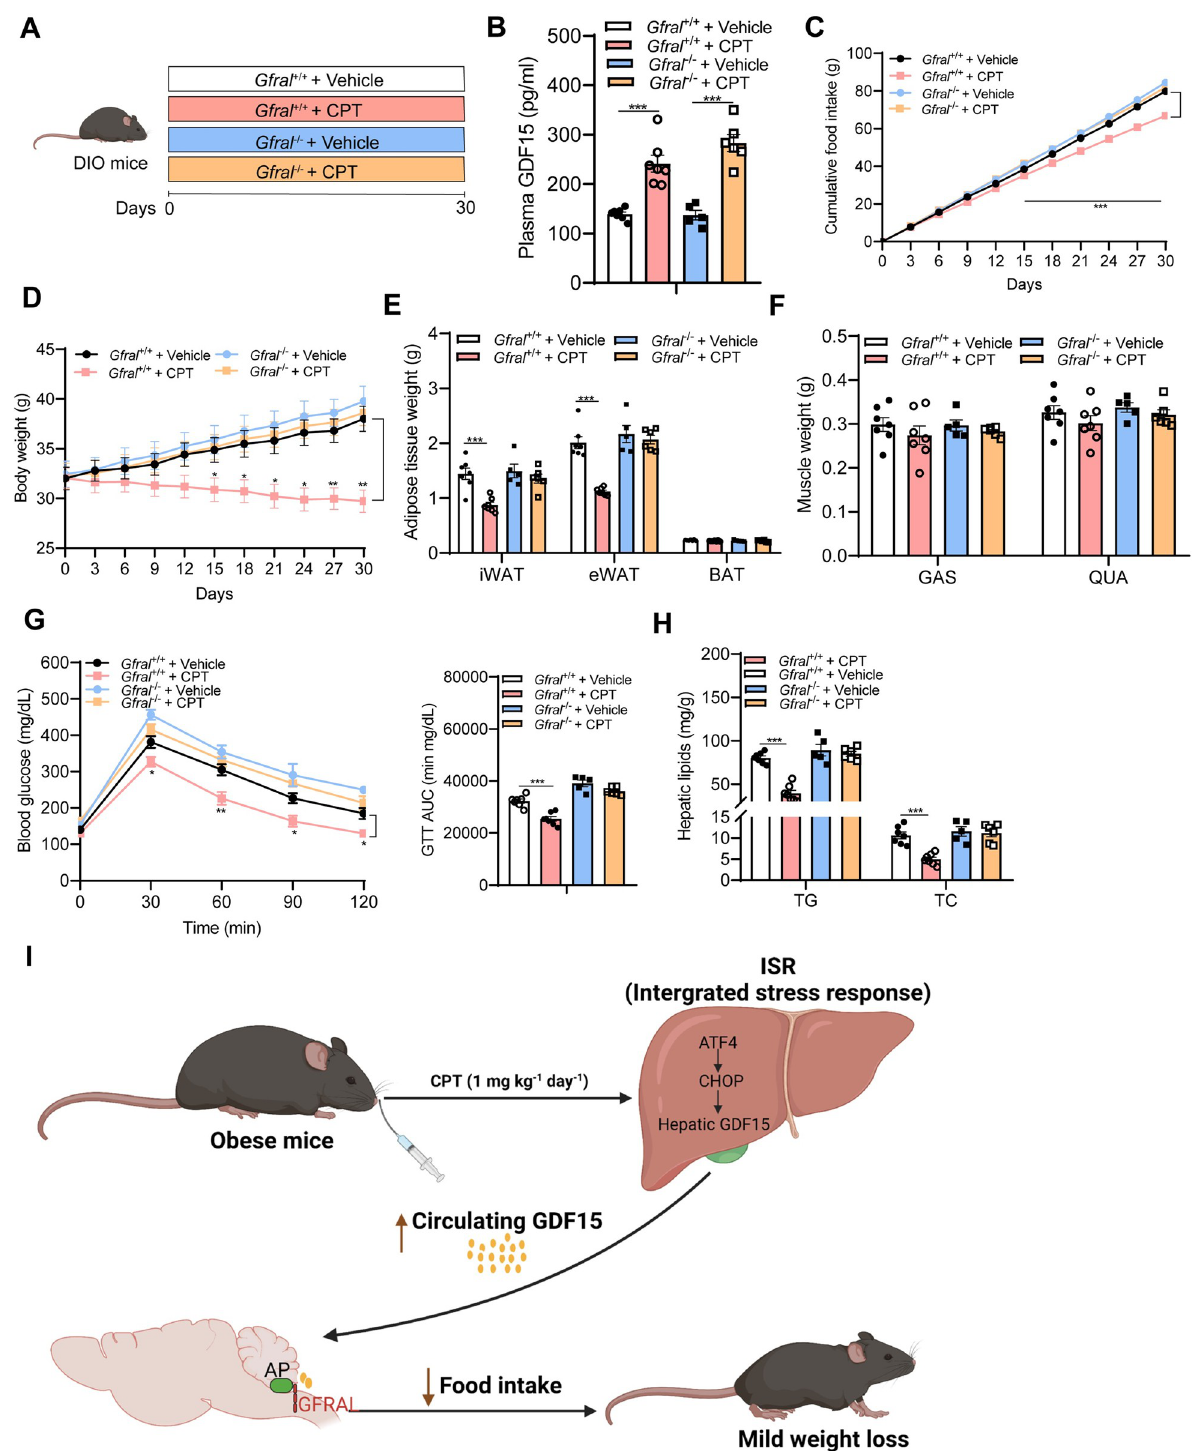
Fig 7. GDF15/GFRAL pathway is required for the weight loss effects of CPT in obese mice. (A-H) Animal protocol 4 : (A) Schematic diagram of mice treatment. WT and Gfral − / − mice were subjected to oral administration of vehicle or CPT (1 mg kg − 1 ) for 30 days. Created with biorender.com. (B) Plasma levels of GDF15 (day 27). (C) Cumulative food intake. (D) Body weight in response to CPT treatment in WT and Gfral − / − mice. (E-F) Weights of adipose tissue and skeletal muscle. (G) GTT and AUC of GTT (day 18). Gfral +/+ (vehicle, n = 7), Gfral +/+ (CPT, n = 7), Gfral − / − (vehicle, n = 5), Gfral − / − (CPT, n = 6). (H) Hepatic TG and TC contents at day 30. Data are presented as mean ± SEM. � P < 0.05, �� P < 0.01, ��� P <